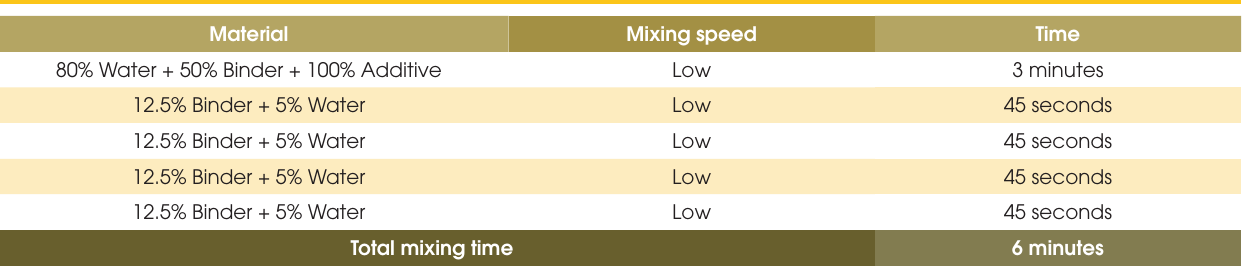
Table 1 – Mixture procedure of the materials, adapted from [21, 22] Material Mixing